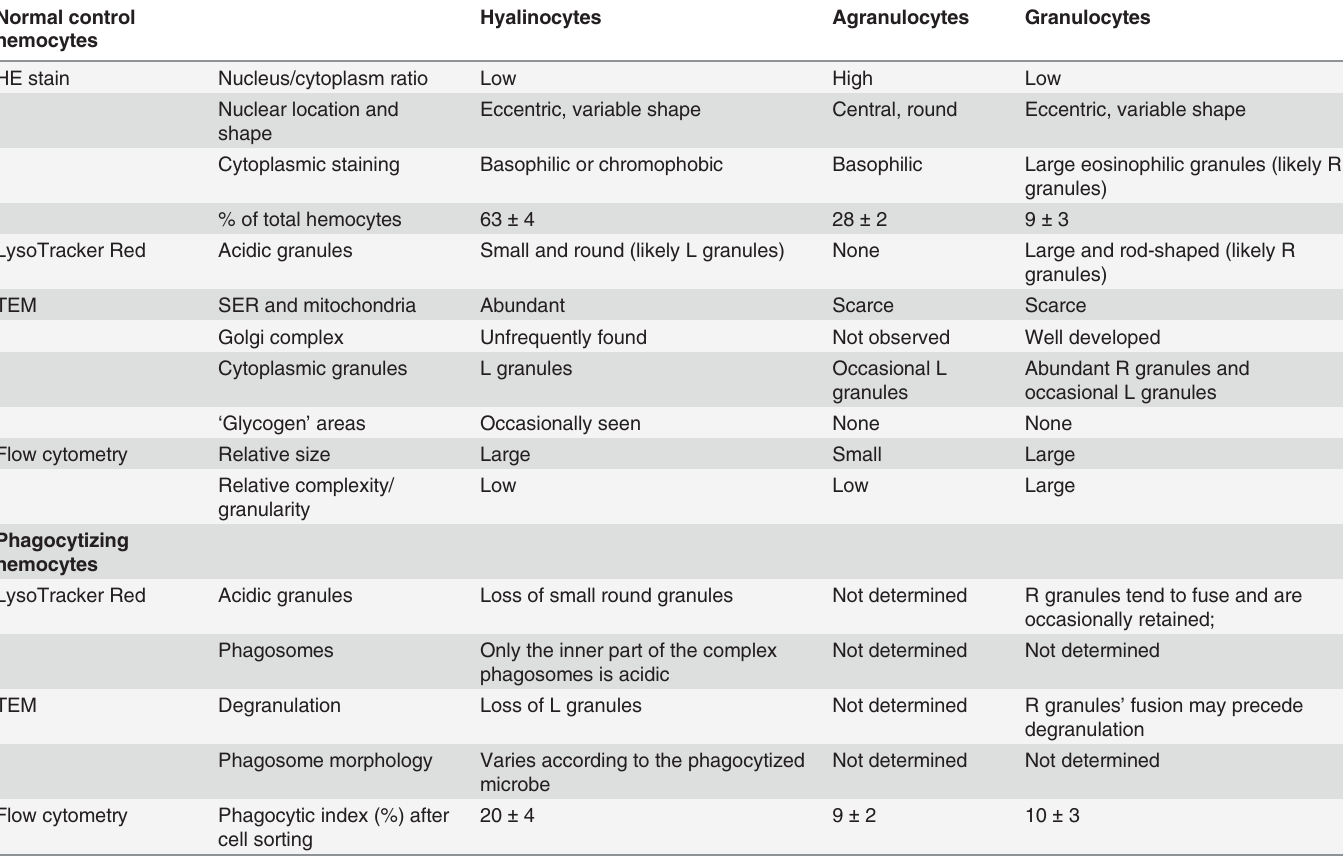
Table 2. Properties of circulating hemocyte types in Pomacea canaliculata